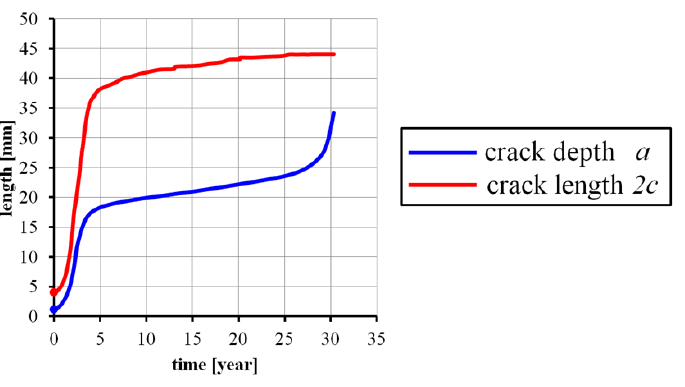
Figure 13: Crack growth